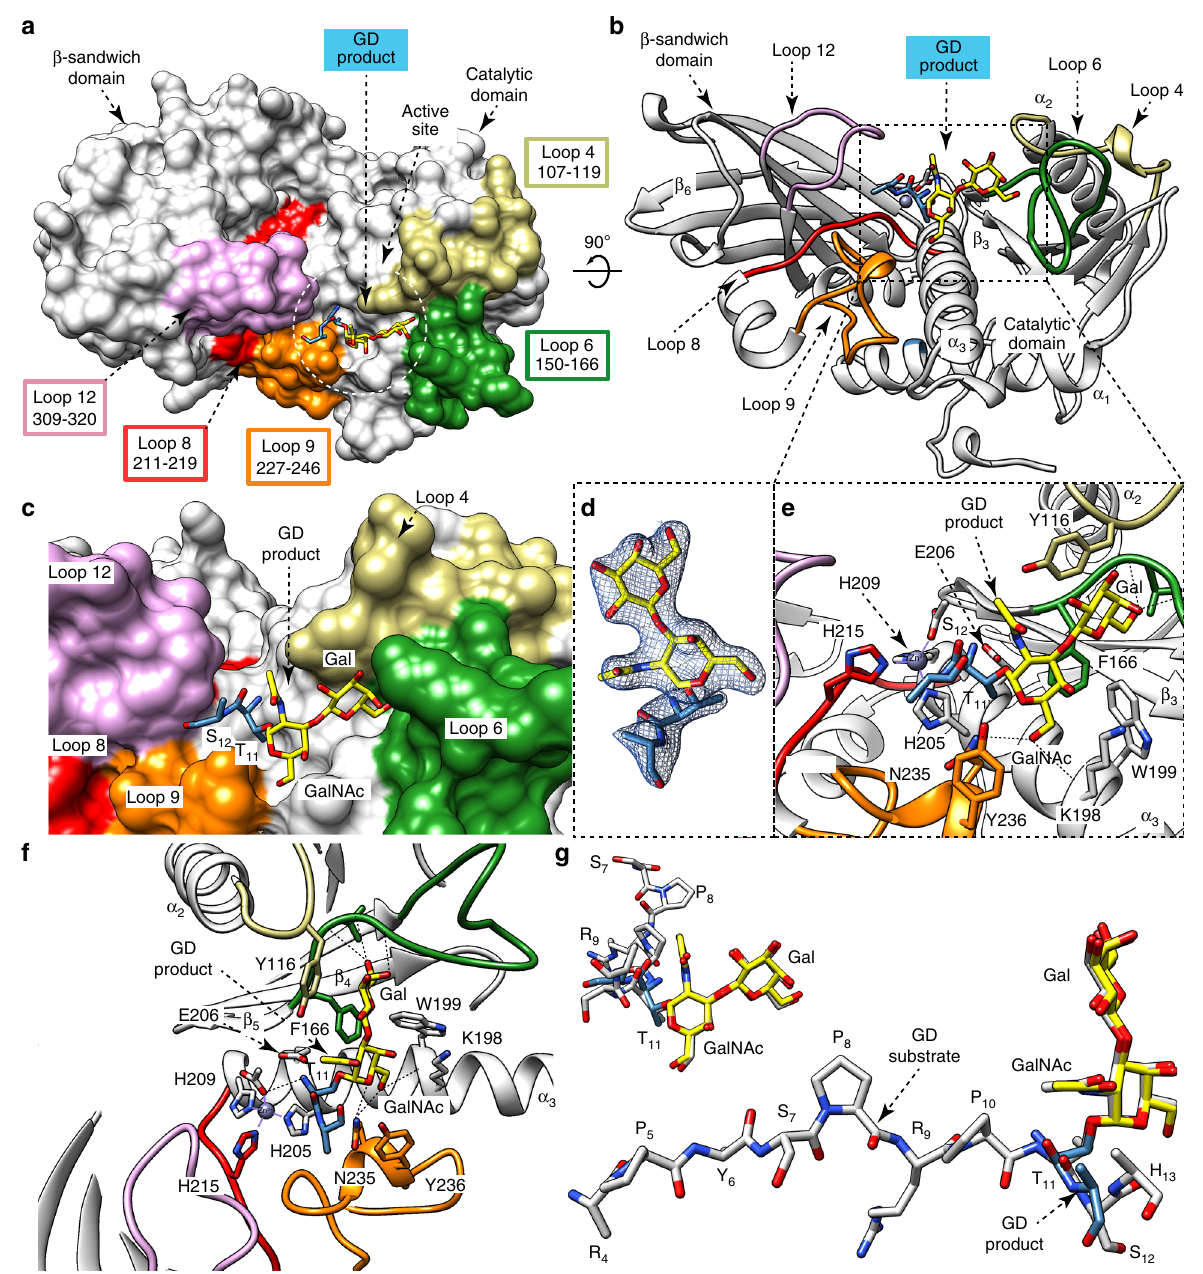
Fig. 3 The O -glycopeptide GD product binding site. a Surface representation of the OgpA WT -GD-PRO crystal structure, with annotated domains and loops. b Cartoon representation of the OgpA WT -GD-PRO crystal structure. c Surface representation of OgpA showing the location of the GD O - glycopeptide product into the active site. d Electron density map of the GD product shown at 1.0 σ r.m.s deviation. e , f Two different cartoon representations of OgpA showing the location of the GD O -glycopeptide product into the active site, the main residues and secondary structure elements. g Two views of the structural superposition of GD O -glycopeptide substrate (gray) and product (blue and yellow) in the OgpA WT -GD-SUB and OgpA WT - GD-PRO crystal structures, respectively. The key hydrogen bond interactions between OgpA and the GD-PRO are shown in dotted lines. The full list of interactions is reported in Supplementary Fig.